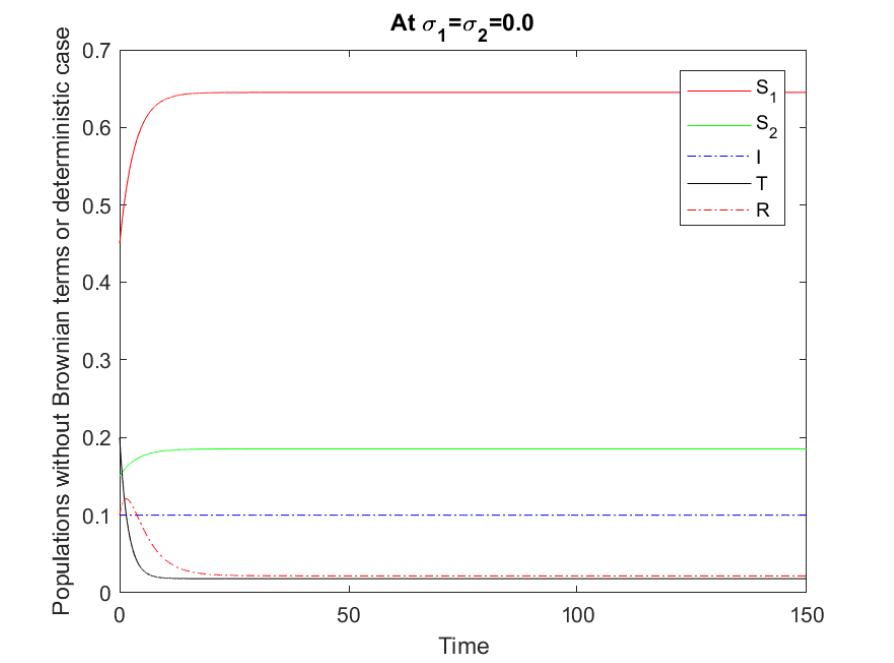
Figure 1. Numerical solution of the model (1) for σ 1 = σ 2 =